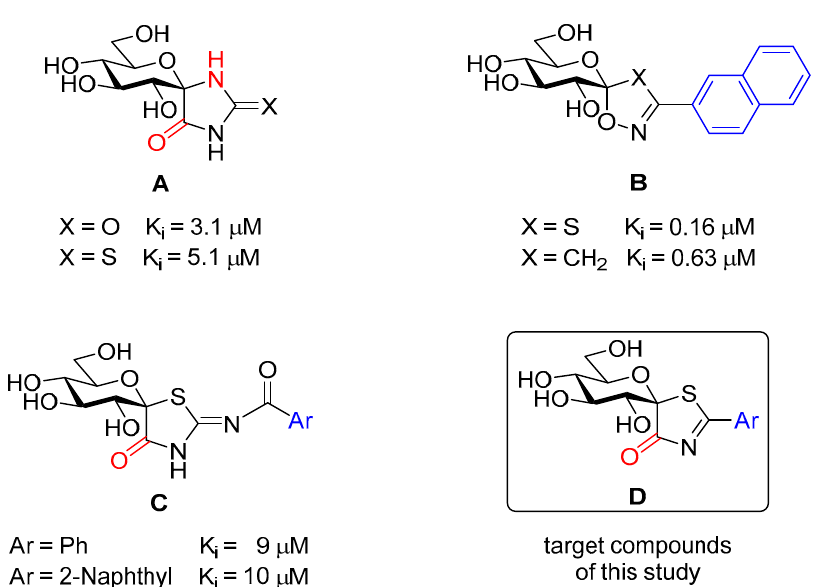
Chart 1. Selected spirobicyclic inhibitors of rabbit muscle glycogen phosphorylase A , B and